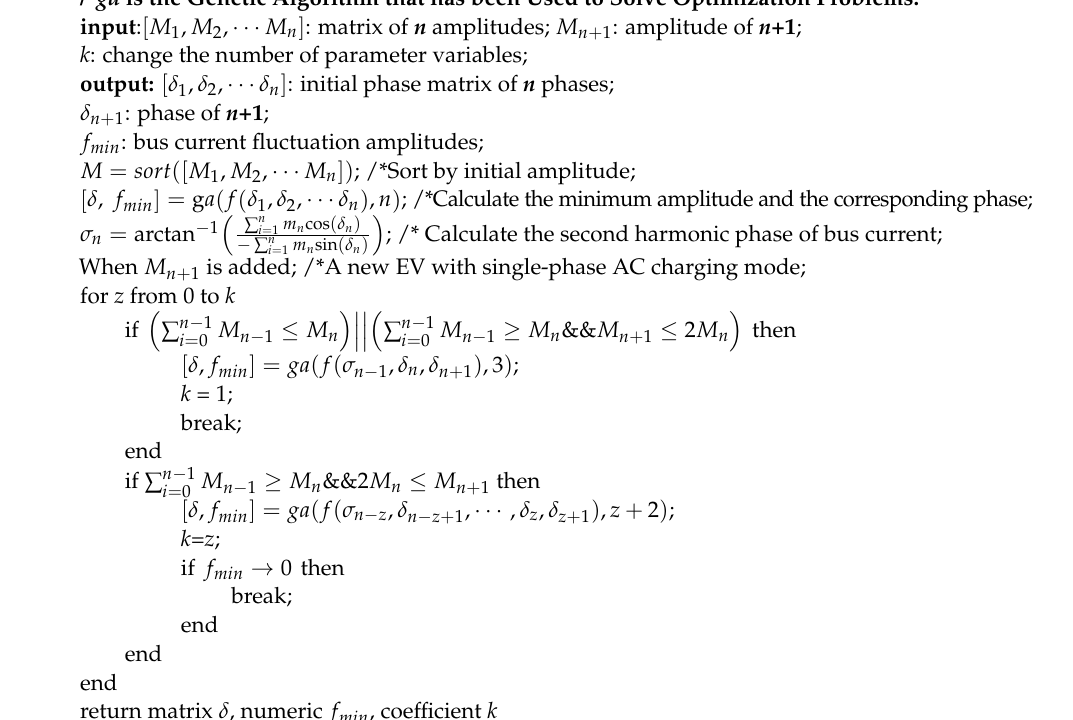
Algorithm 1 An Optimization Control Algorithm Implementation /* ga is the Genetic Algorithm that has been Used to Solve Optimization